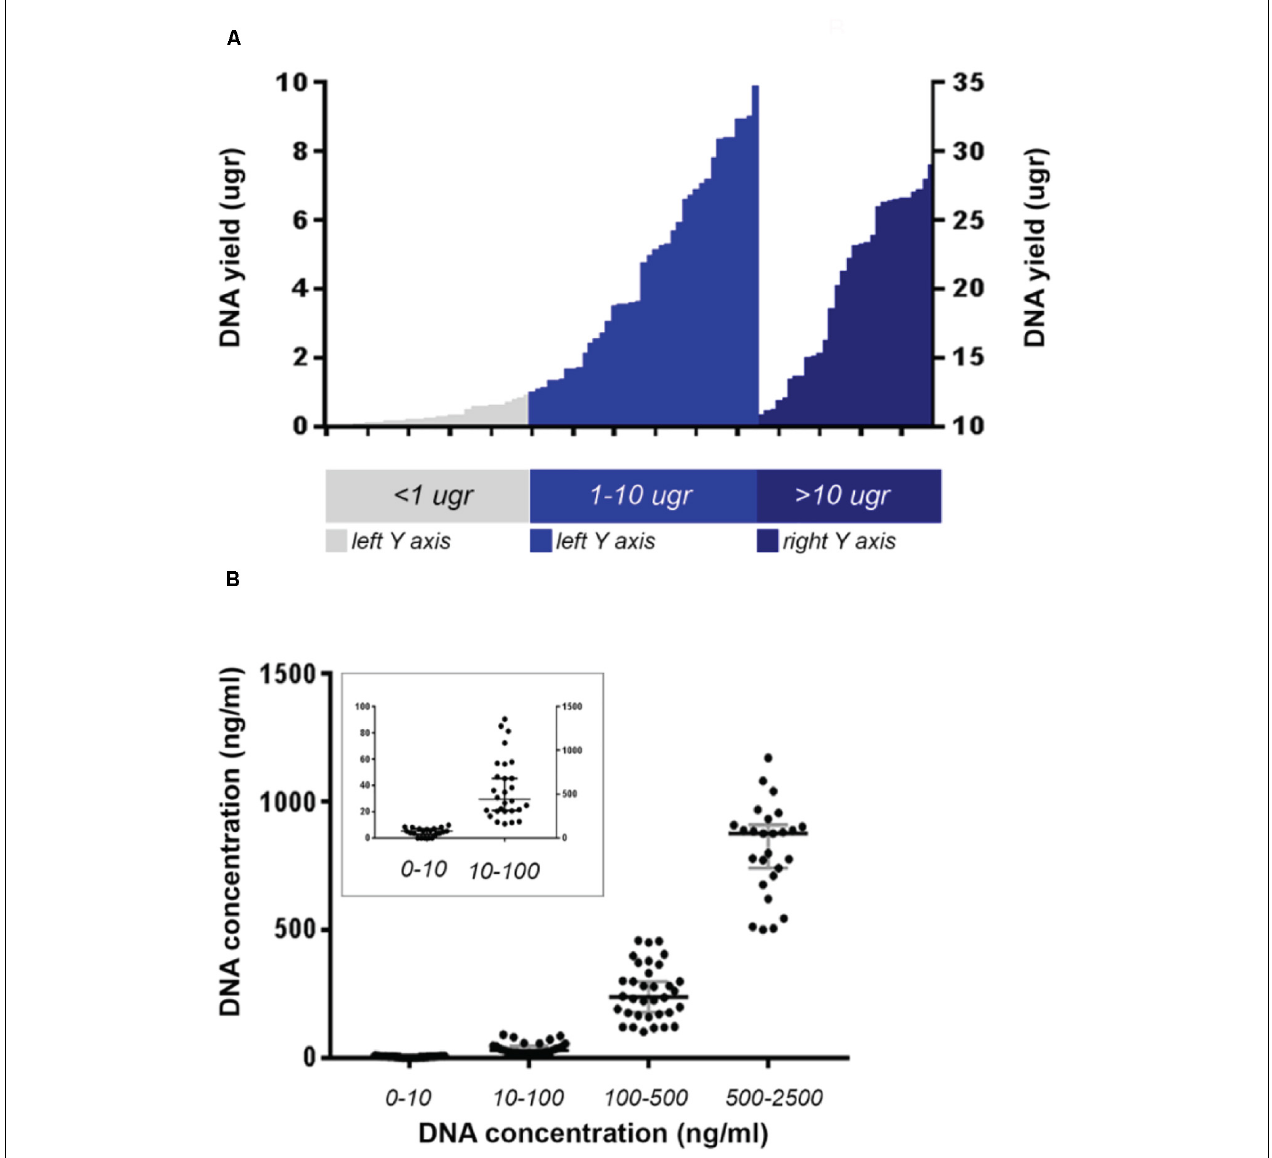
FIGURE 2 | Maximum DNA yield of the whole analyzed cohort from PROSPECT-C and PROSPECT-R patients. (A) Cases with DNA yield > 10 µ g are plotted against right Y -axis. (B) Cases divided according to their DNA concentration. Median value and with 95% CI represented in gray bars. In the small square cases with DNA concentration < 100 ng/ml are plotted against the left Y